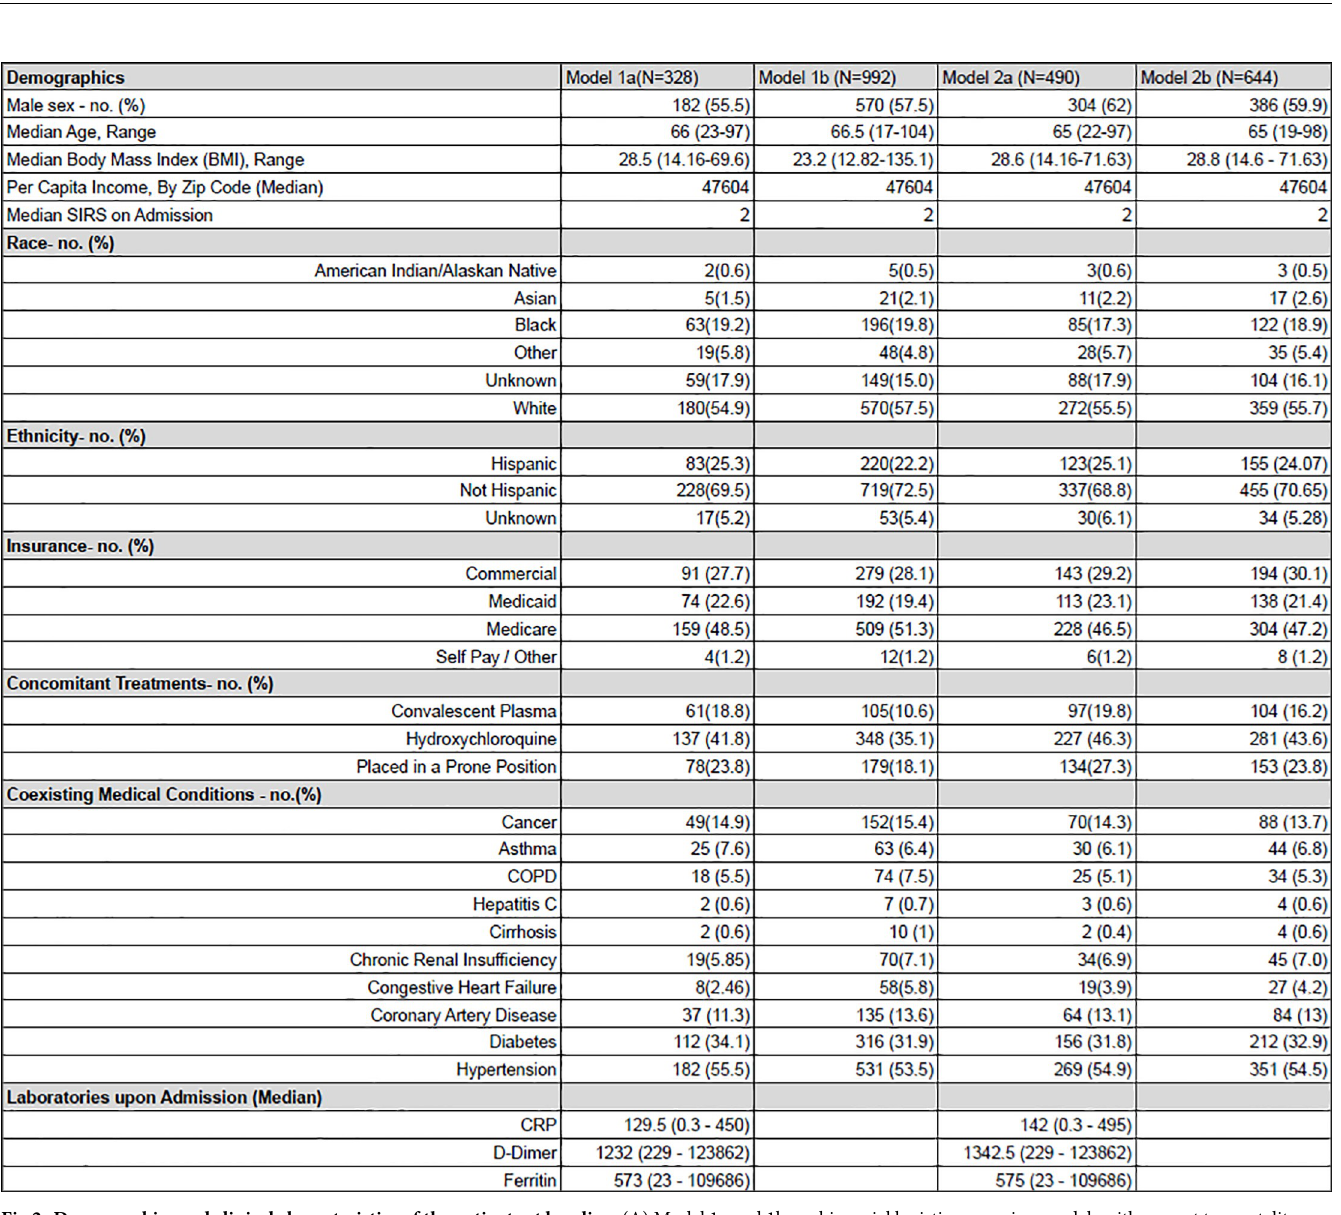
Fig 2. Demographics and clinical characteristics of the patients at baseline. (A) Model 1a and 1b are binomial logistic regression models with respect to mortality. Lab values were included in 1a, but not 1b. Model 2a and 2b are binomial logistic regression models with respect to mortality within 96 hours of admission. Again, lab values were included in 2a, but not 2b. Demographic information presented represents individuals included in the specified model. Percentages are denoted within parenthesis. Per capita income was determined by patient’s zip code using incomebyzipcode.com. The systemic inflammatory response syndrome score (SIRS) was calculated for hospital admission using the initial white blood cell count, temperature, pulse and respiratory rate present in the ED. Race and ethnicity were self- reported. Values differ due to individuals missing essential data being excluded from the